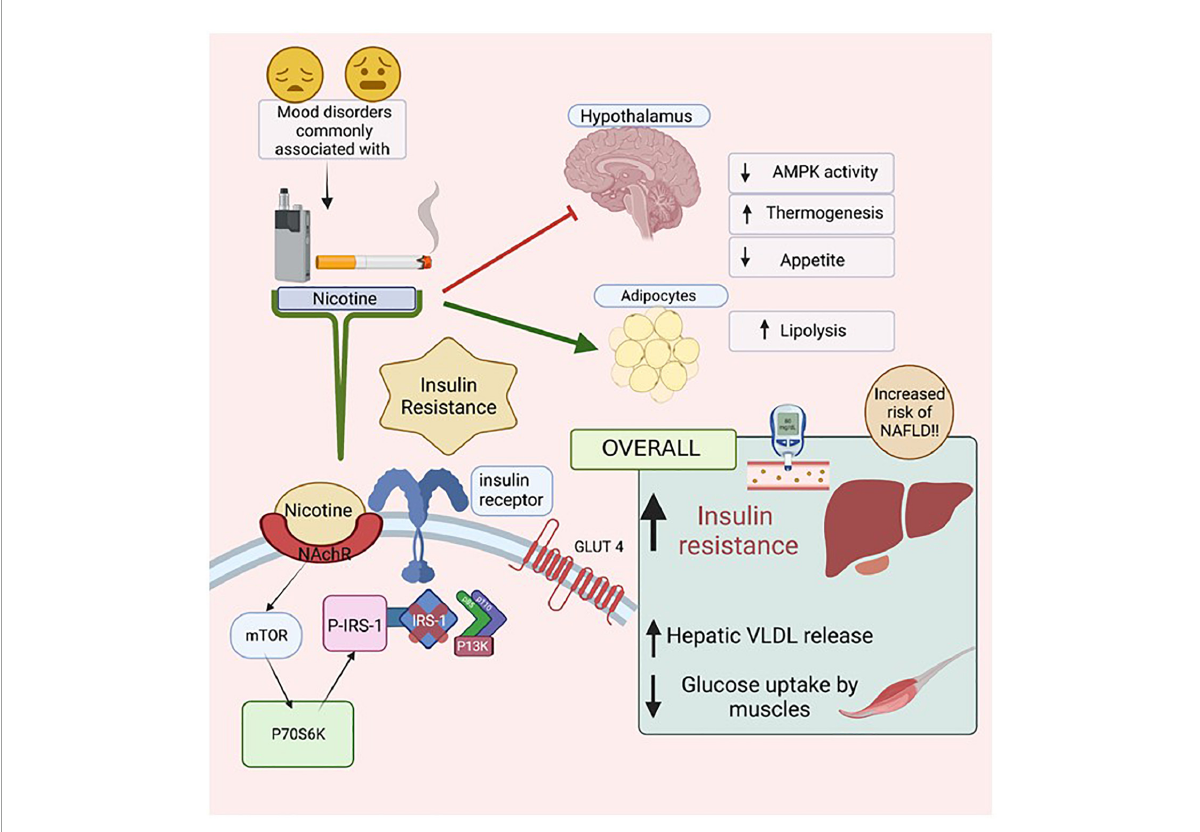
FIGURE6 The Effects of Nicotine on insulin resistance and NAFLD. Mental health illnesses, including mood disorders, have high co-incidence rates with smoking. Nicotine, found in both cigarettes and electronic vapes, has been linked to increasing insulin resistance. When Nicotine binds to its receptor, it activates mTOR which then activates P70S6K which activates P-IRS-1, preventing Insulin Receptor Substrate (IRS-1) from binding to the cytoplasmic domain of the insulin receptors. As a result, intracellular pathway PI3K will not be activated resulting in eventual insulin resistance. Due to such reactions in the Hypothalamus, there is a decrease in AMPK activity, increased thermogenesis and reduced appetite. In adipocytes, there is an increase in lipolysis, leading to increased levels of free fatty acids in the body. Figure created with